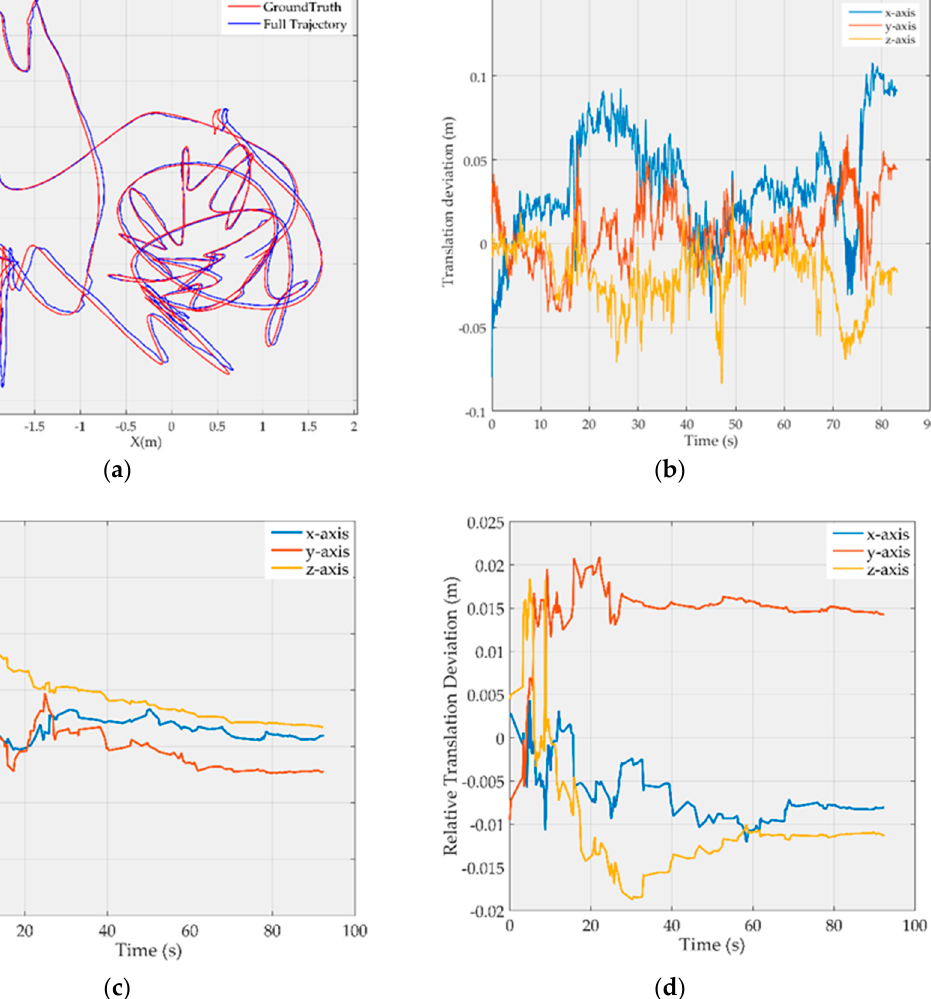
Figure 3. Results for the V1_03_difficult image sequence after visual-inertial initialization: ( a ) Full trajectory after visual-inertial initialization; ( b ) Translation deviation with respect to the ground truth; ( c ) Rotation deviation of camera-to-IMU transformation; ( d ) Translation deviation of camera-to-IMU transformation.